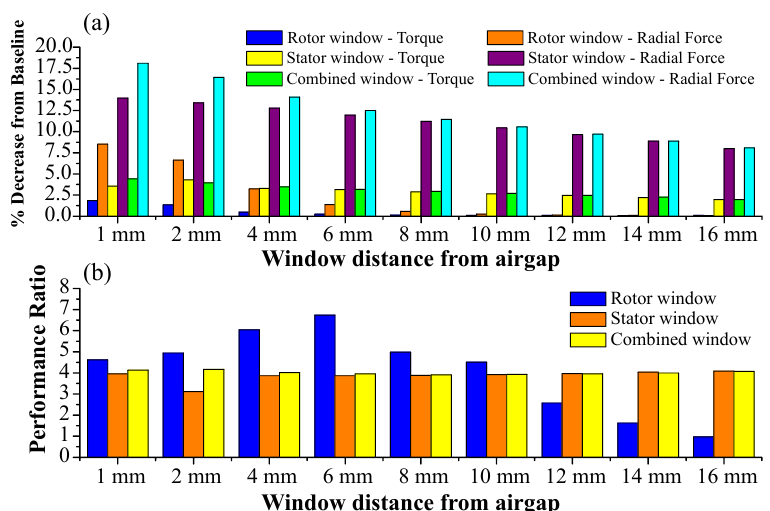
Figure 21. Rotor, stator, and combined circular window design comparisons based on the proximity to the airgap: ( a ) change in static torque and radial force and ( b ) performance ratio.